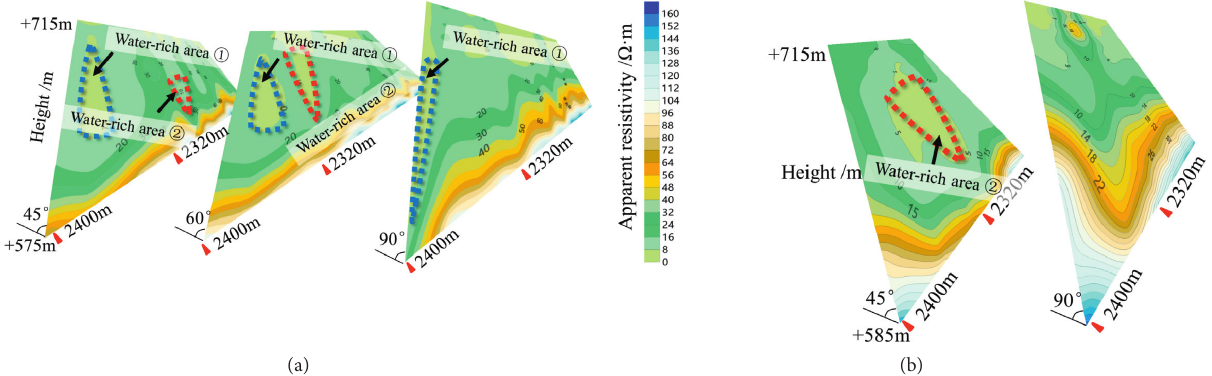
Figure 9: Visualization of water rich area detection: (a) south roadway, (b) measure roadway.